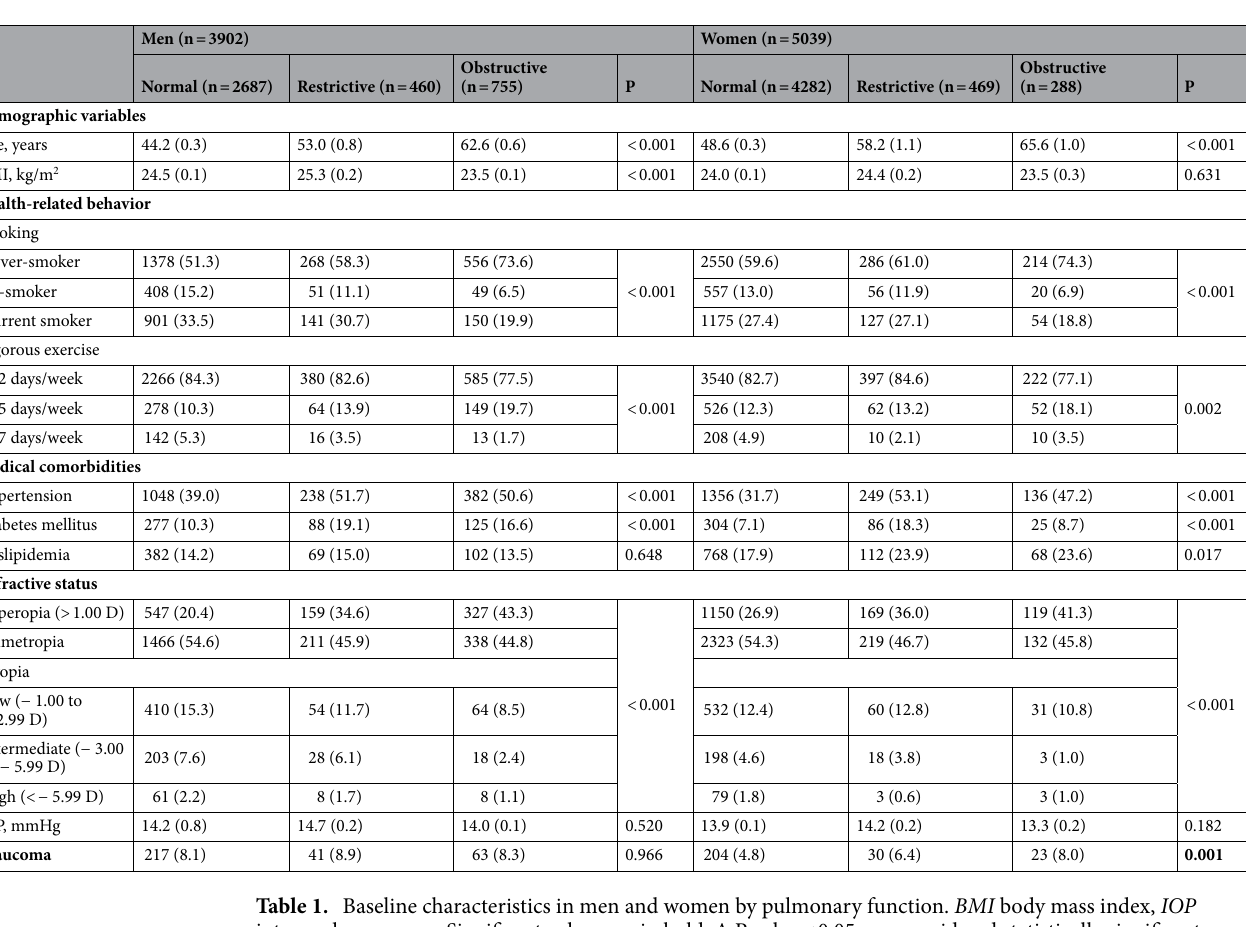
Table 1. Baseline characteristics in men and women by pulmonary function. BMI body mass index, IOP intraocular pressure. Significant values are in bold. A P value < 0.05 was considered statistically significant.